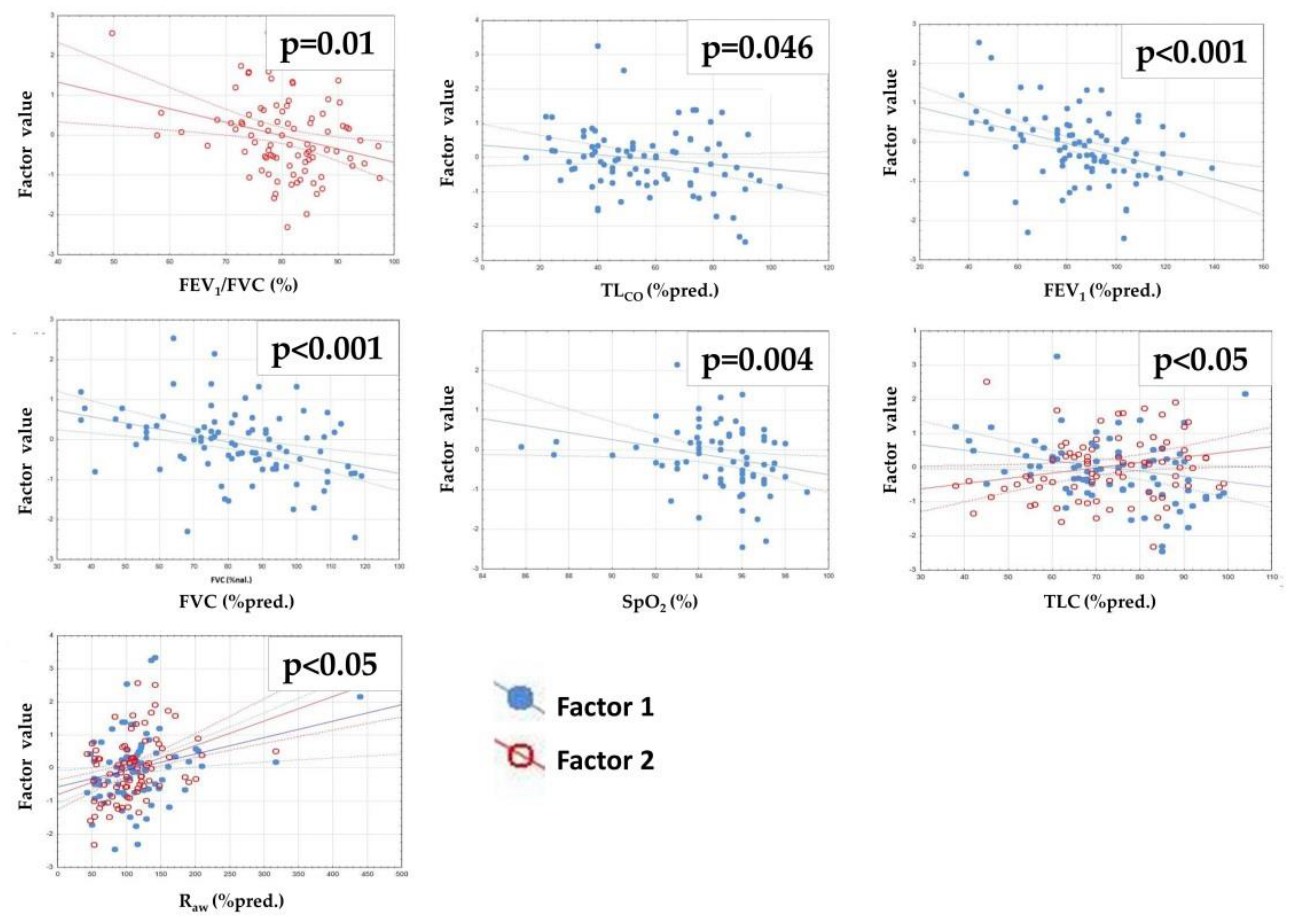
Table 6 and Figure 4 present correlations between oscillometric factors and other lung function and exercise test results. There was a negative relationship between FEV 1 /FVC and Factor 1 and between Factor 2 and TL CO , FEV 1 , FVC and SpO 2 . A positive correlation with Factor 1 and a negative correlation with Factor 2 was observed for TLC. Airway resistance was positively related to both factors.